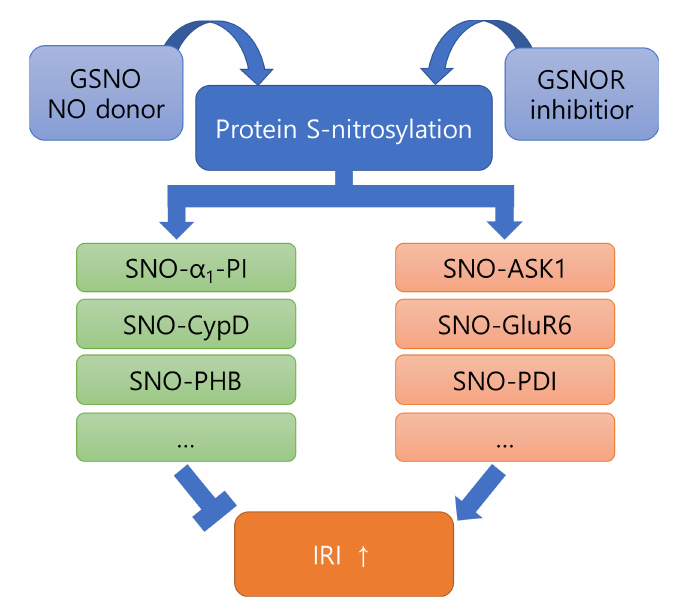
Figure 2. The role of S-nitrosylation in IRI. S-nitrosylation causes a functional change of the nitro- sylated target protein, which tends to inhibit or promote severe progression of IRI. This suggests that inhibition of SNO-proteins in the orange box should be considered for more efficient use of NO donors or GSNOR inhibitors for the treatment of